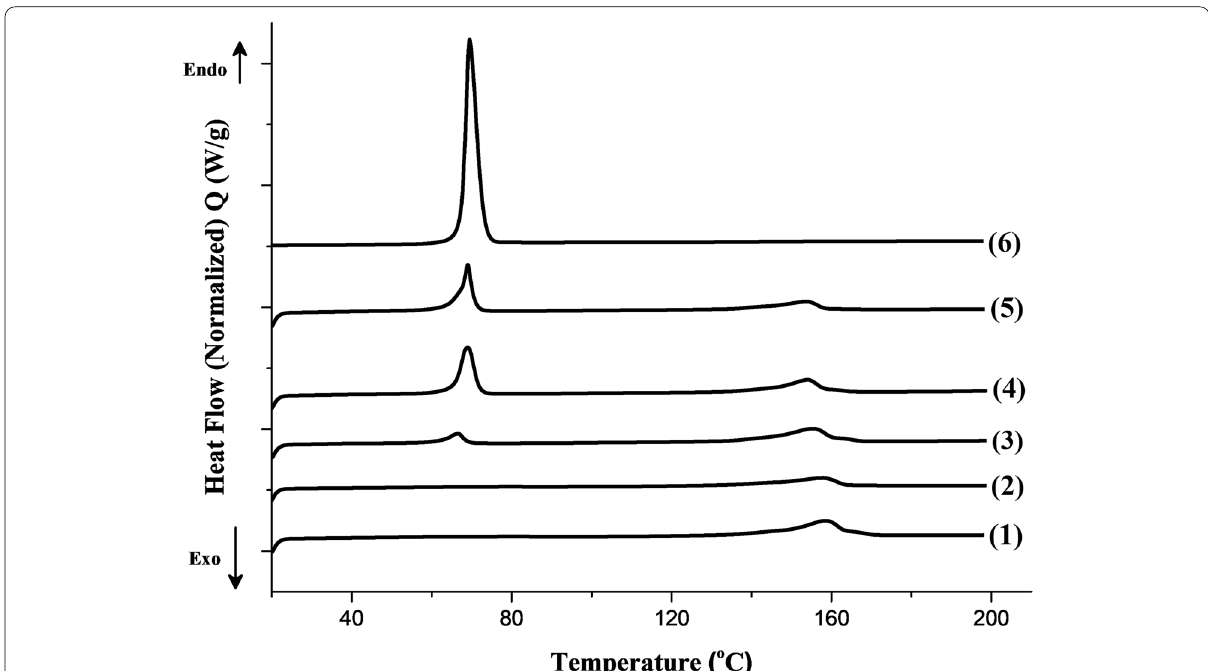
Fig. 6 DSC thermograms of the first heating cycles of (1) pure PHBV samples, (2) PHBV/SiO 2 composite fibers (unmodifed), (3) PHBV fibers with 2 wt.% SA modification, (4) PHBV fibers with 12 wt.% SA modification, (5) PHBV/SiO 2 composite with 5 wt.% SA modification and (6) pure